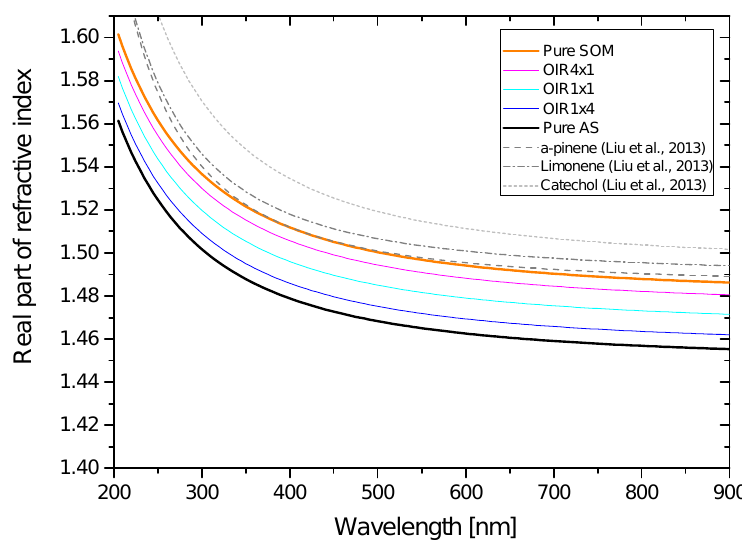
Figure B1. Real part of the refractive index, n , for aqueous mixtures of ammonium sulfate (AS) and secondary organic matter (SOM) with varying OIRs extrapolated to dry conditions (lines in various colors). For comparison, the parametrizations of Liu et al. (2013) for SOM obtained by ozonolysis of α -pinene, limonene and catechol are given (gray